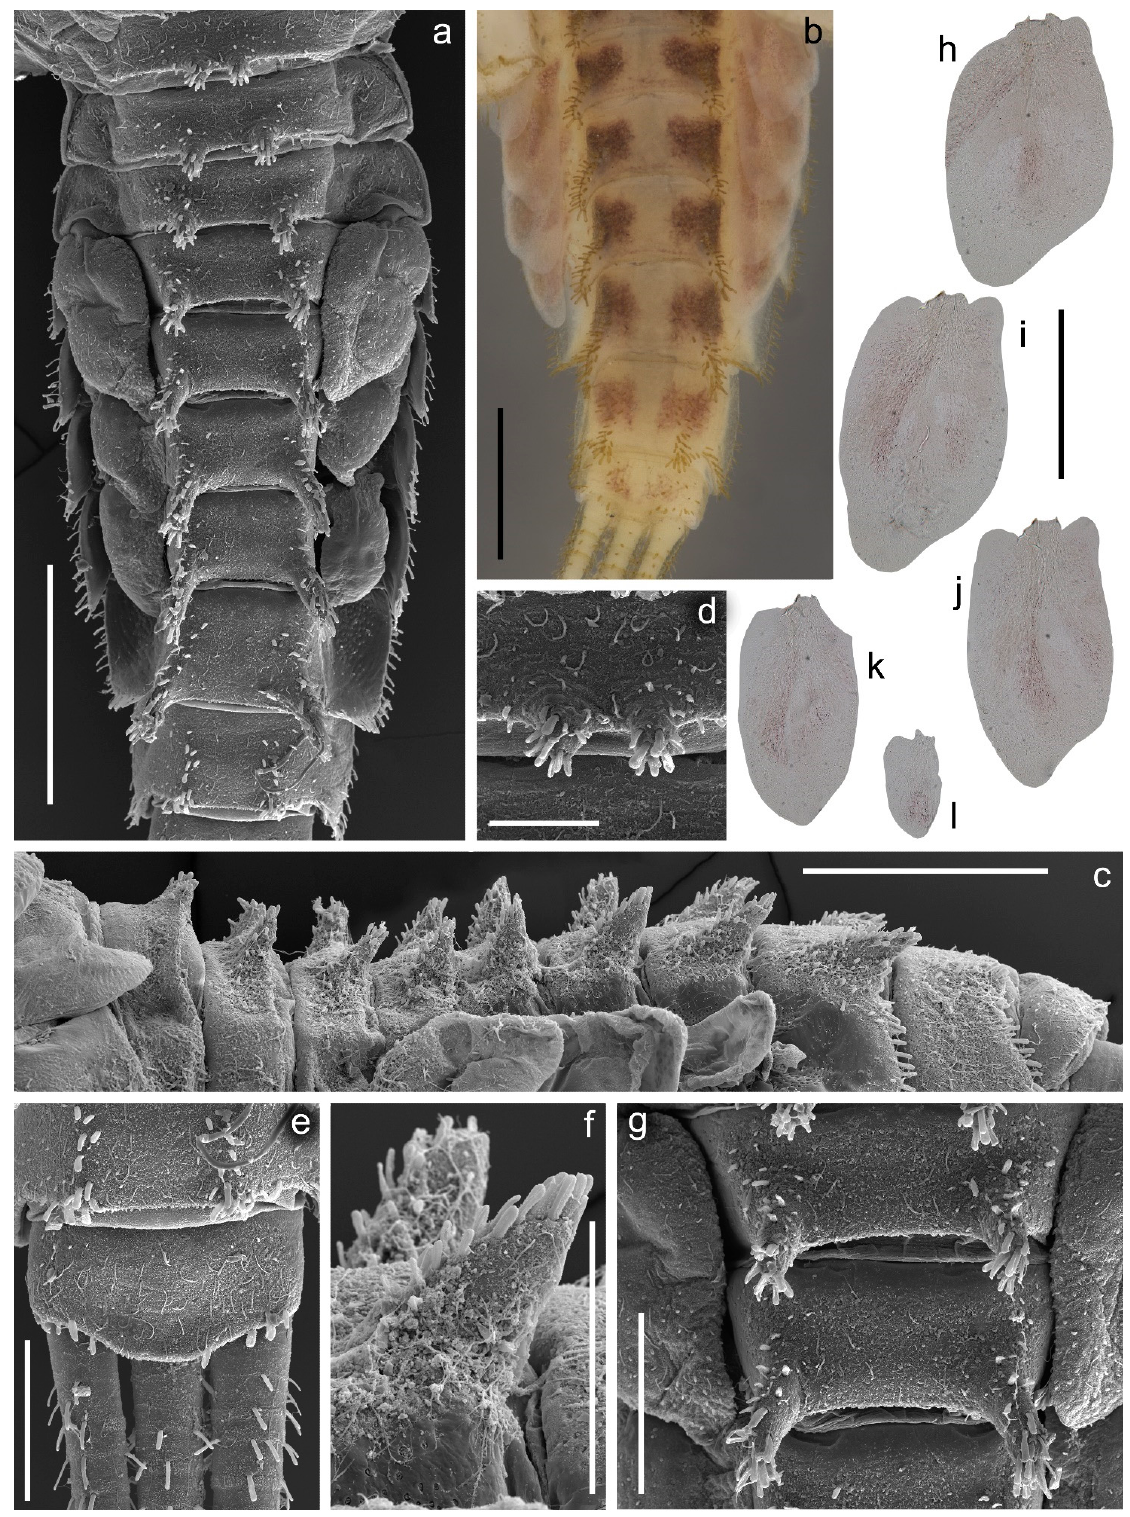
Figure 5. Larva of Serratella leonidi Martynov & Palatov, sp. nov. , holotype ( b ) and paratypes ( a , c – l ). ( a ) Abdomen, dorsal view, ( b ) terga V–X, dorsal view, ( c ) abdomen, lateral view, ( d ) submedian tubercles of tergum I, dorsal view, ( e ) terga IX and X, and basal parts of caudal filaments, dorsal view, ( f ) submedian tubercles of tergum VI, dorsal view, ( g ) submedian tubercles of terga IV and V, dorsal view, ( h – l ) gills III–VII. Scale bars: ( a , b )—0.5 mm, ( c )—1 mm; ( d )—0.1 mm, ( e – g )—0.2 mm; ( h – l )—0.25